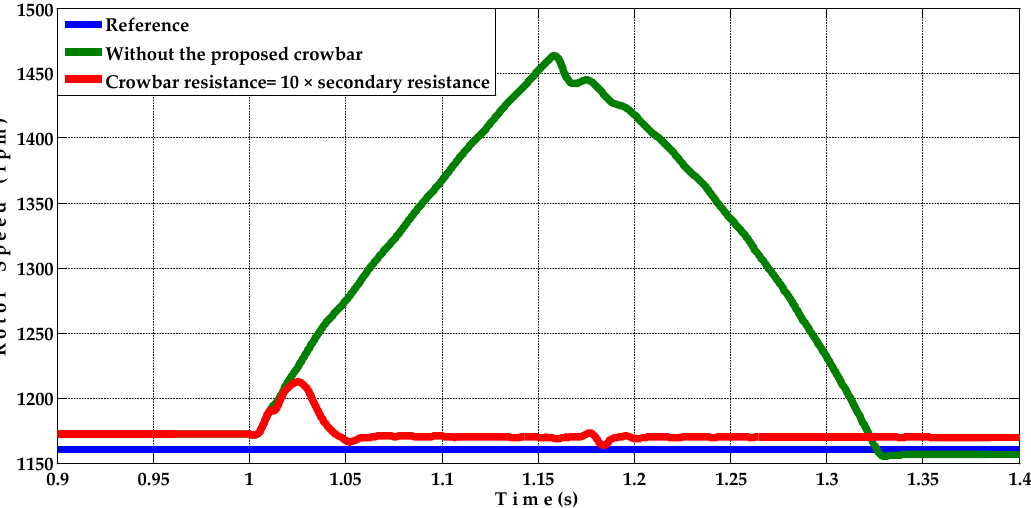
Figure 8. Rotor speed of BDFRG with and without the proposed crowbar under symmetrical fault occurrence.